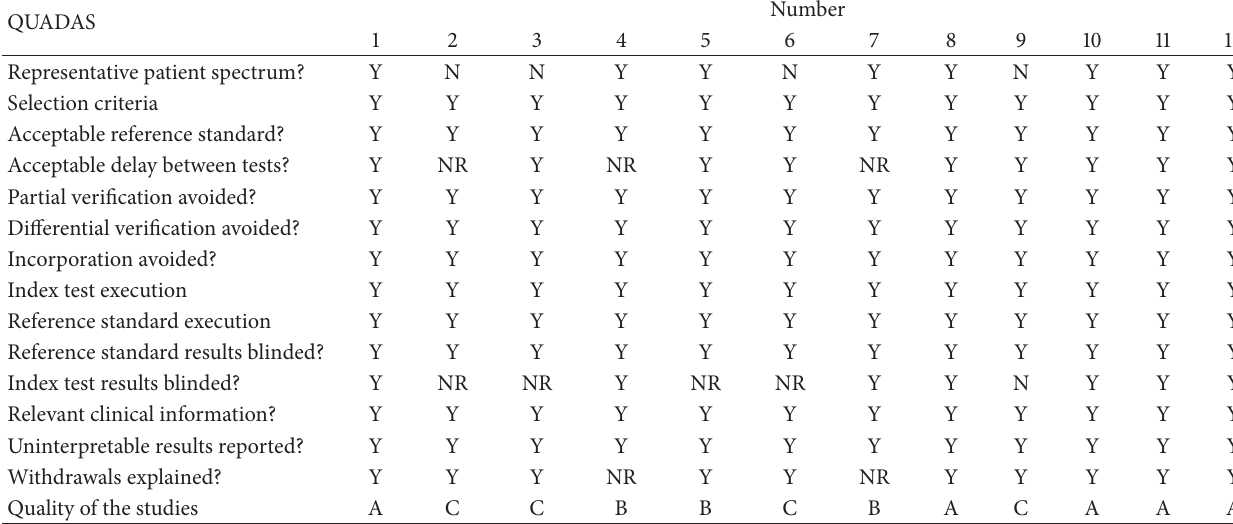
Table 2: Summary of methodological quality of the included studies on the basis of the review authors’ judgments on the 14 items in the QUADAS checklist for each